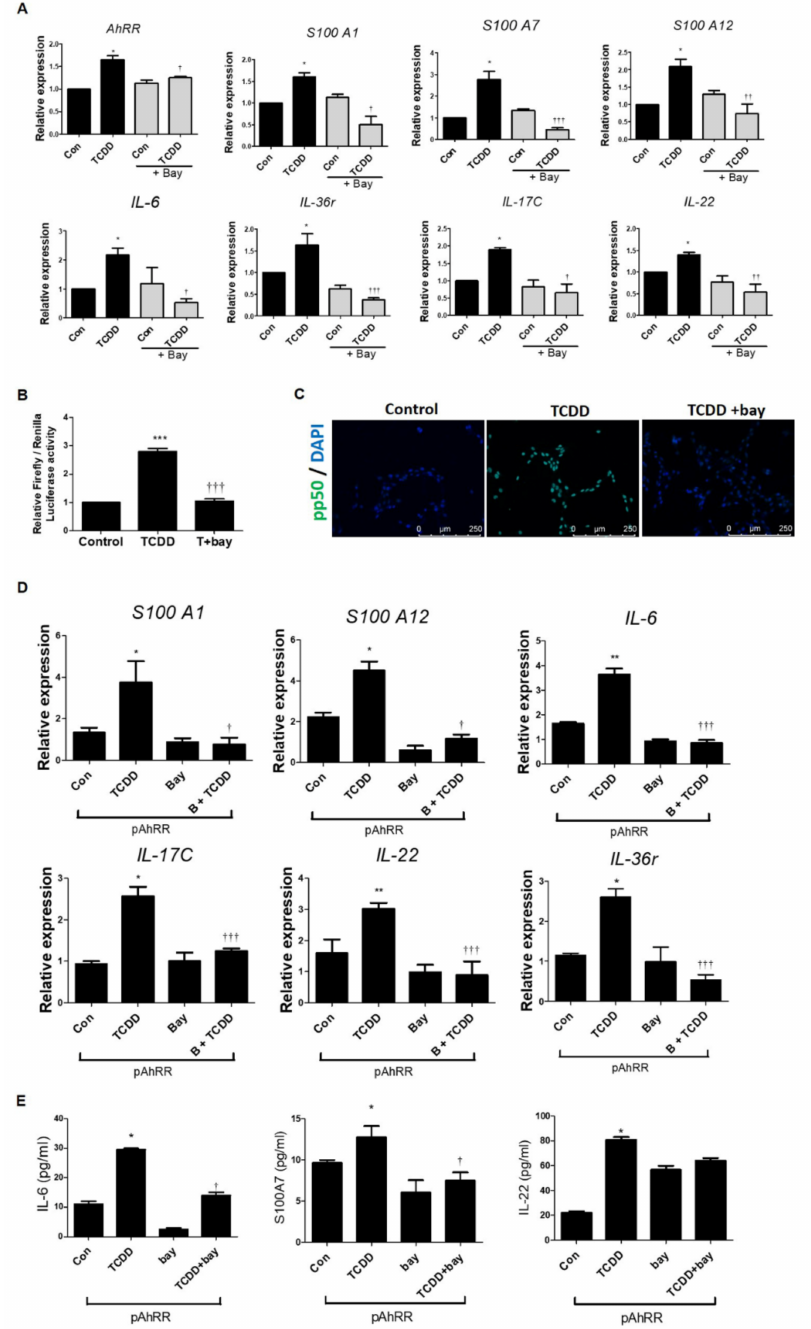
Figure 6. Effect of TCDD on AhRR by NF- κ B signaling pathway in HaCaT cells. HaCaT cells were pre-treated with bay 11-7082 (NF- κ B inhibitor) at 3 nM for 1 h, and then treated with TCDD (500 nM) for 24 h. (A) mRNA expression levels of pro-inflammatory cytokines in HaCaT cells along with TCDD were examined by qPCR. (B) The NF- κ B promoter region of activation was determined by the luciferase reporter assay. (C) Translocation of NF- κ B pp50 was determined by immunofluorescence staining (scale bar: 250 µ m). ( D ) mRNA expression levels of pro-inflammatory cytokines in HaCaT cells along with AhRR-overexpressed HaCaT cells were examined by qPCR. ( E ) Protein production of pro-inflammatory cytokines in HaCaT cells along with AhRR-overexpressed HaCaT cells were examined by ELISA. Values are means ± SEM. * p < 0.05 vs. control, ** p < 0.01 vs. control, *** p < 0.001 vs. control, † p < 0.05 vs. TCDD, †† p < 0.01 vs. TCDD, ††† p < 0.001 vs. TCDD, ** p < 0.01 vs. pAhRR+TCDD, ††† p < 0.001 vs.